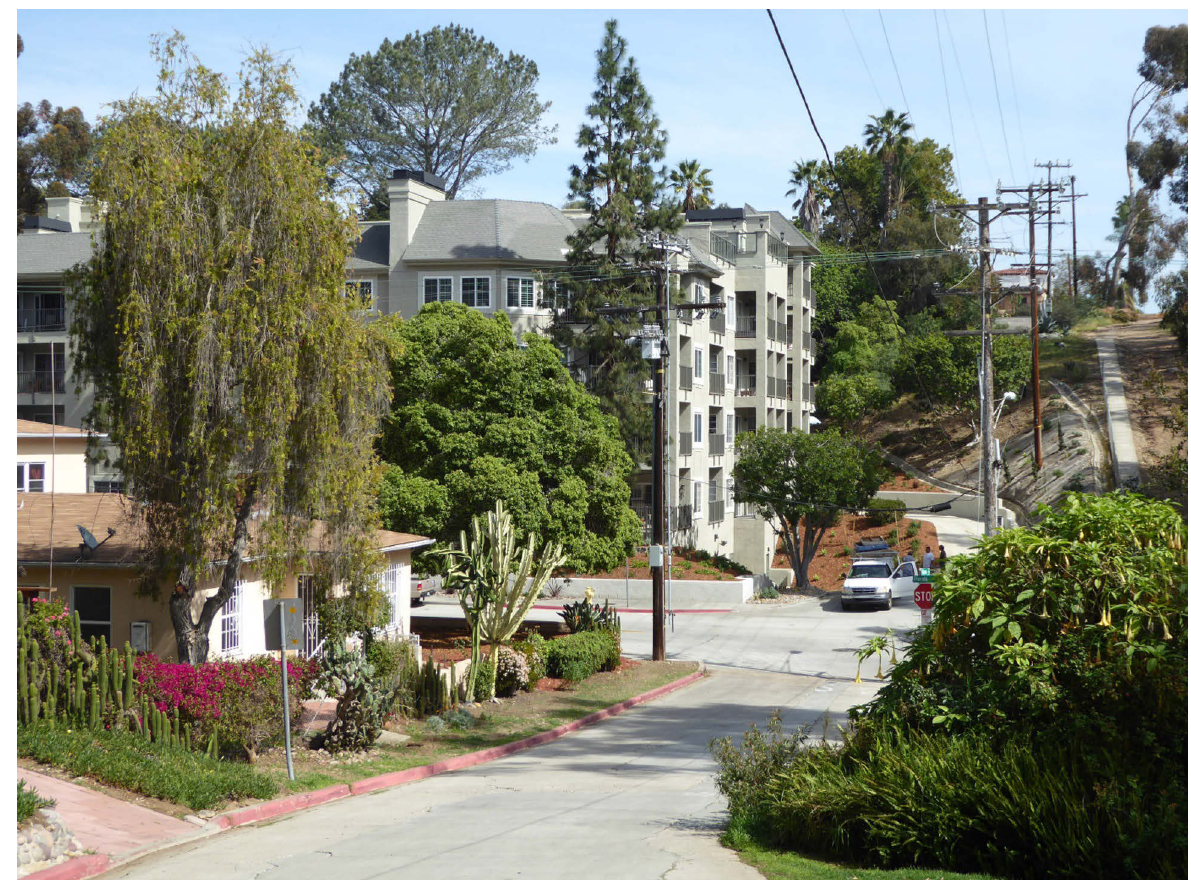
Fig. 1. URFSURB in North Park, San Diego, where apartment blocks increasingly intrude into classical single- family-home districts (photo: Olaf Kühne